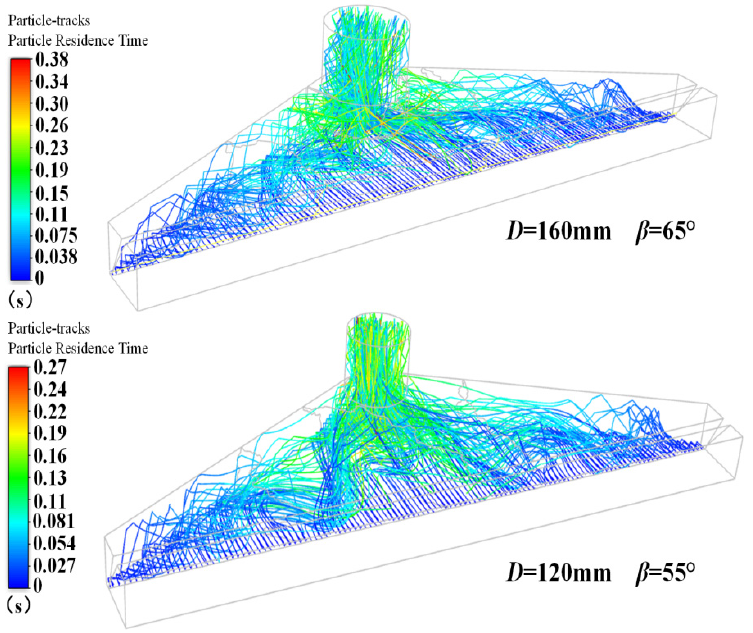
Figure 10. Comparison of particle trajectories for different sizes of dust extraction ports.